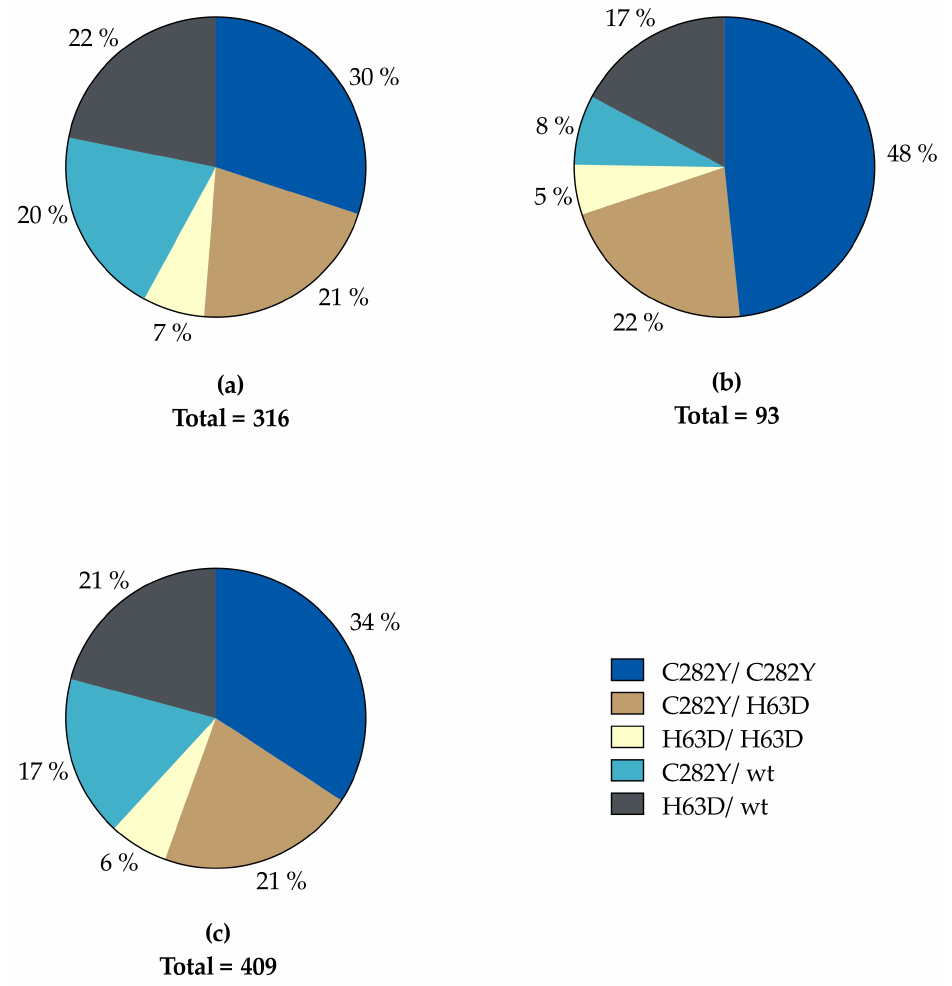
Figure 1. Distribution of HFE genotypes in ( a ) men, ( b ) women and ( c ) the total study population. wt, wildtype.